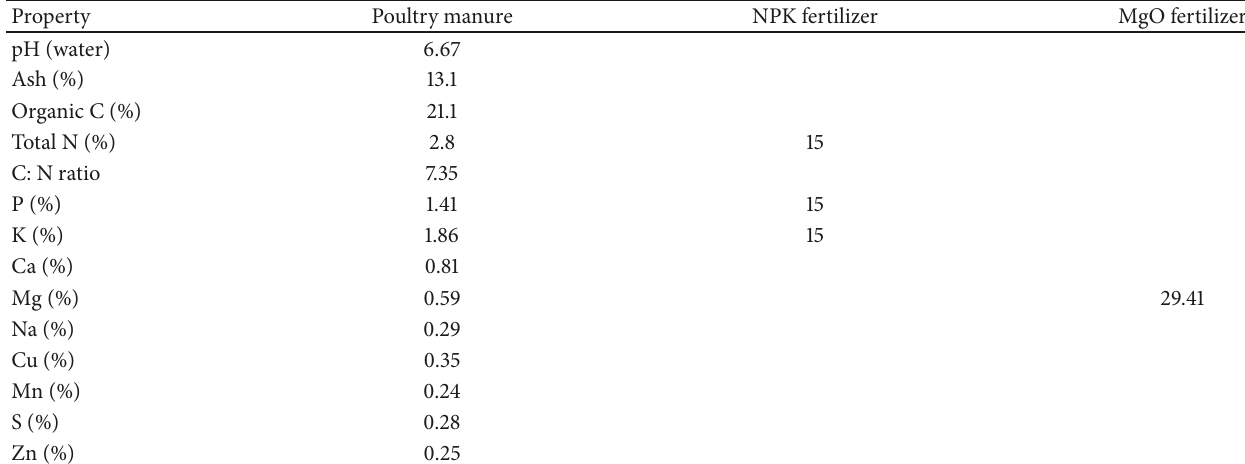
Table 2: Chemical analysis of poultry manure and chemical fertilizers